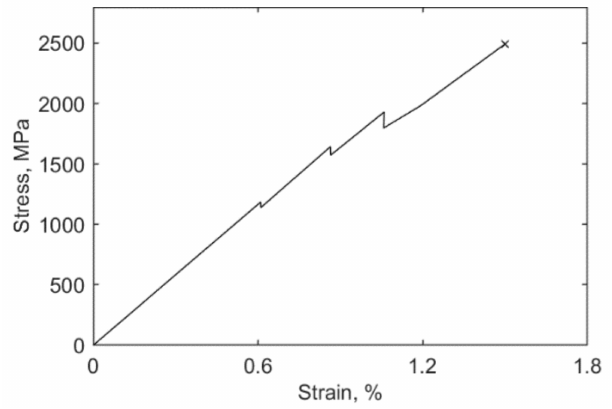
Figure 2. Typical stress vs. strain curve for a CFRP